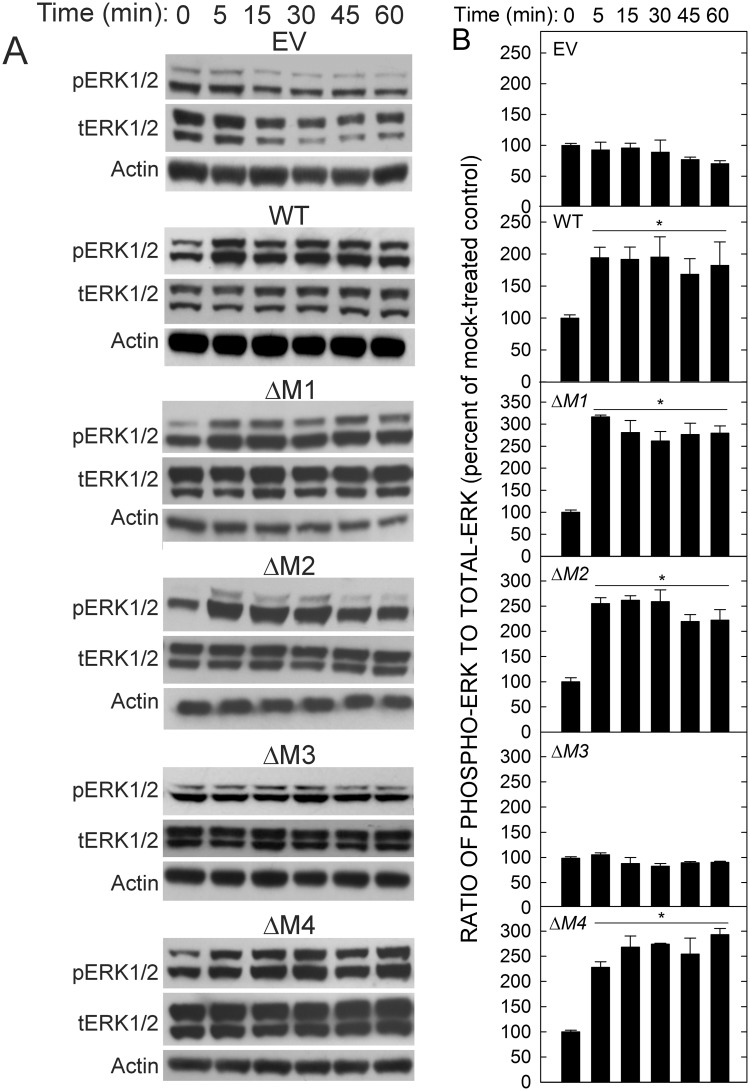
The M3 motif is required for HARE•Hep-mediated ERK activation.Cells stably expressing EV or WT or the indicated HARE CD mutant (ΔM1, ΔM2, ΔM3 or ΔM4) were grown, processed and then incubated with 10 μg/ml (709 nM) UFH for 0–60 min, as indicated, and processed as described in Methods. A. Equal amounts of cell lysate (25 μg) were resolved in 10% SDS-PAGE and transferred to nitrocellulose membranes. Western blot analysis was performed with Ab against pERK1/2 (top panels). The same membranes were stripped and reprobed with Ab against tERK1/2 (middle panels) and then with anti-actin Ab (bottom panels). B. Blots from three independent experiments (n = 3) were digitized by scanning and densitometry analysis was performed to determine the pERK:tERK ratios, which were normalized to actin levels. The results are presented as mean percent ± SEM of the normalized pERK:tERK ratio compared with the time-zero (mock addition) value as 100%. An asterisk indicates that all time points for the WT, ΔM1, ΔM2, and ΔM4 samples (but not the EV or ΔM3 samples) were significantly different than their respective time-zero values (p < 0.05).